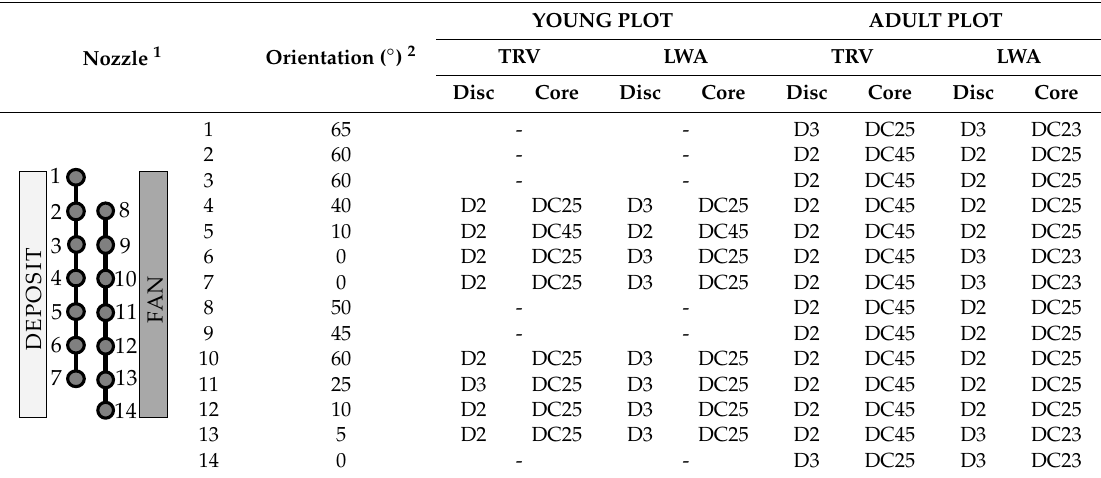
Table 6. Configuration and location of disc-core nozzles for treatments with the air-blast sprayer. Positions that do not have a nozzle assigned were closed during applications.